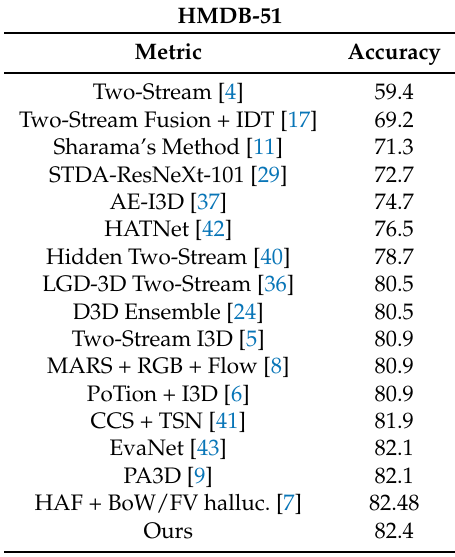
Table 7. Comparison with State-of-the-Art Methods on HMDB-51 (Accuracy